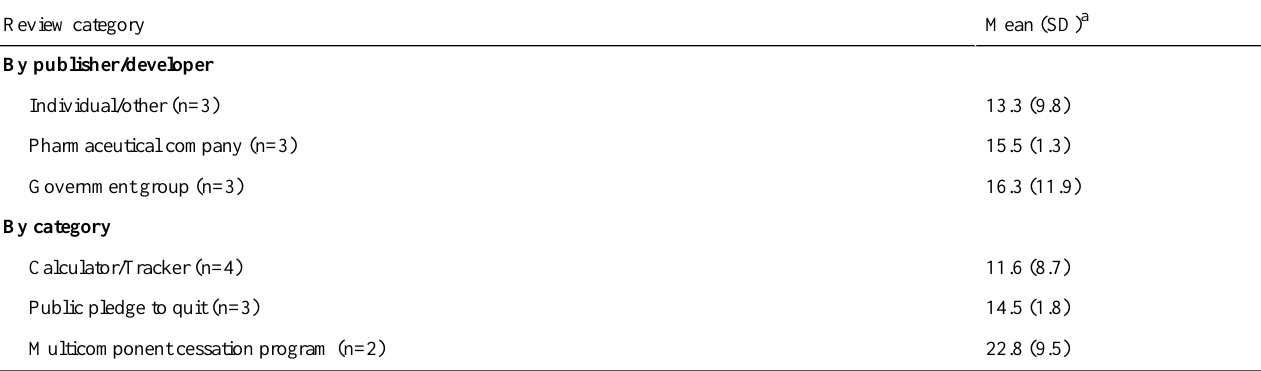
Table 2. Facebook app adherence index summary score by publisher/developer and category